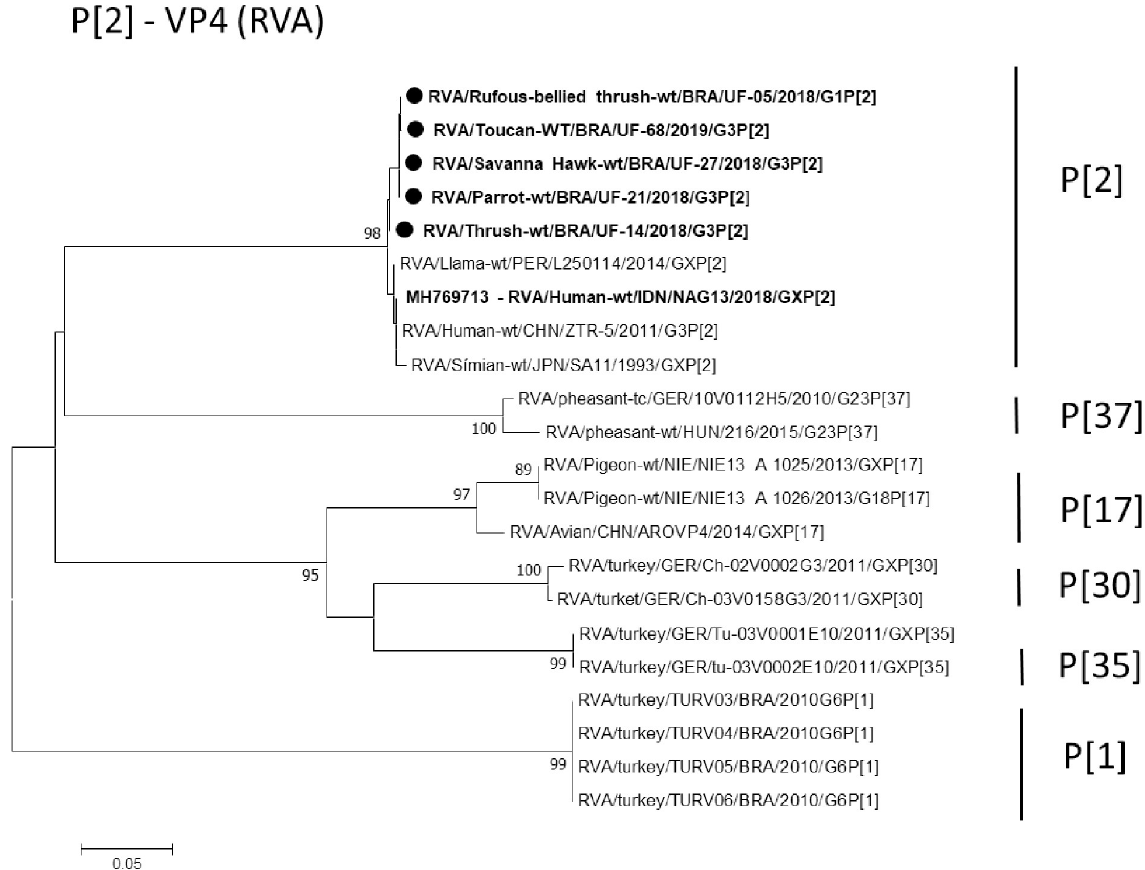
Fig 4. Phylogenetic tree based on the sequence alignment of the avian RVA VP4 gene. The sequence of this study is represents in bold, and the black color depicts the birds. The numbers next to the nodes indicate bootstrap values > 70.